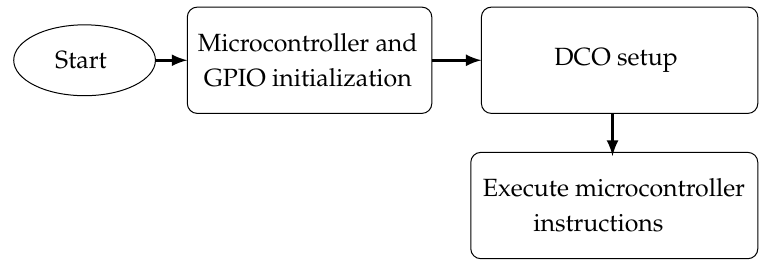
Figure 3. Clocking MSP430F5529LP using the internal clock